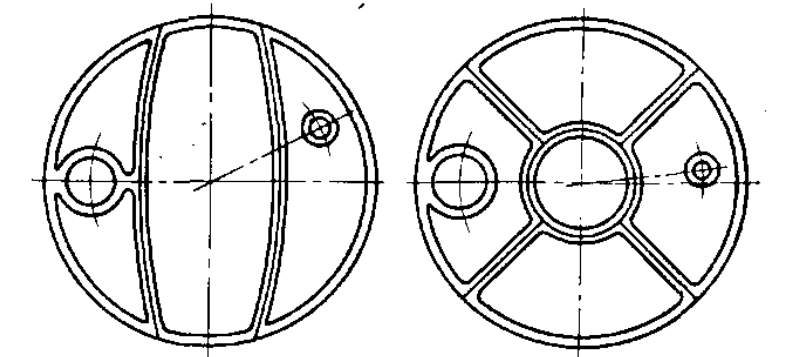
Fig. 1. Variants of petal (left) and segmental (right) division of the bottom of large